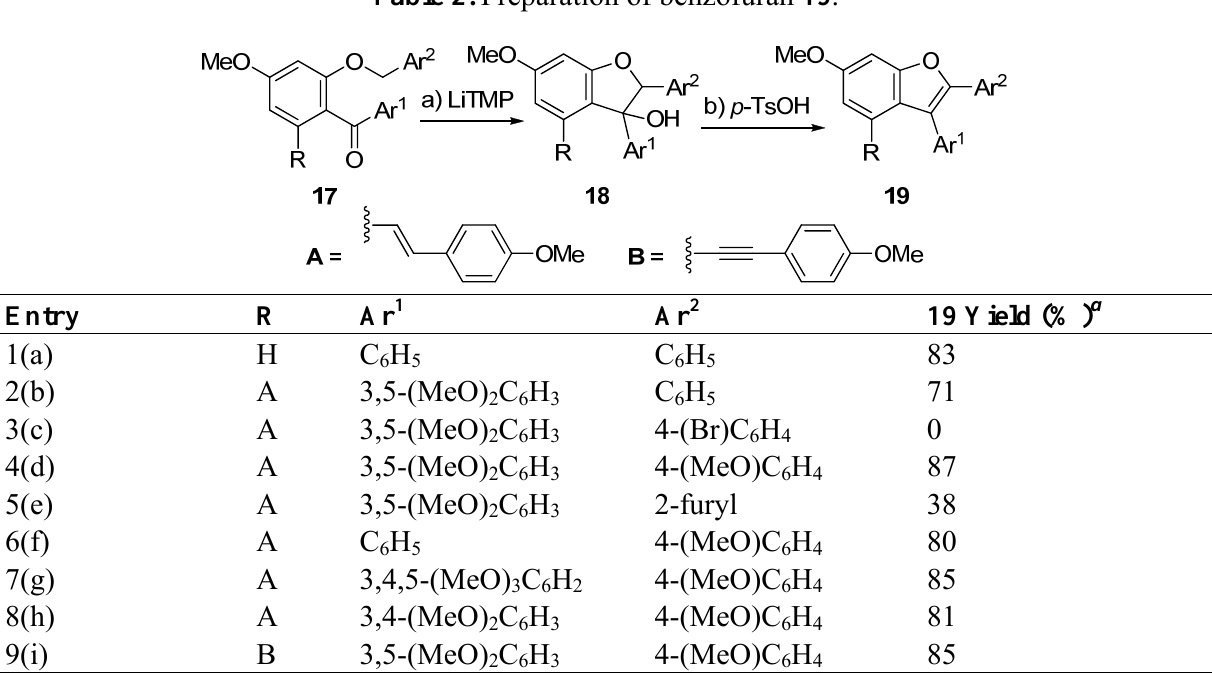
Table 2. Preparation of benzofuran 19